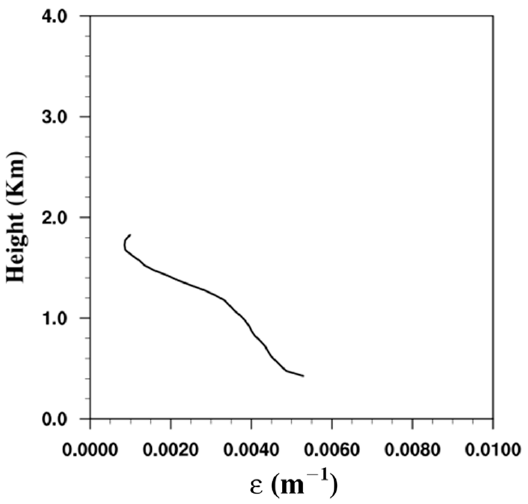
Figure 6. Entrainment rate variation with height.